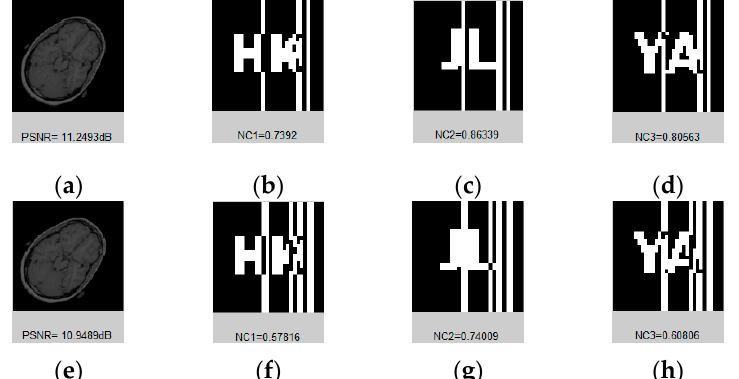
Figure 18. Under rotation attacks: ( a ) Rotation (clockwise) 40 ◦ ; ( b ) the extracted watermark 1 under rotation (clockwise) 40 ◦ ; ( c ) the extracted watermark 2 under rotation (clockwise) 40 ◦ ; ( d ) the extracted watermark 3 under rotation (clockwise) 40 ◦ ; ( e ) Rotation (clockwise) 45 ◦ ; ( f ) the extracted watermark 1 under rotation (clockwise) 45 ◦ ; ( g ) the extracted watermark 2 under rotation (clockwise) 45 ◦ ; ( h ) the extracted watermark 3 under rotation (clockwise) 45 ◦ . Table 6. Data of rotation attacks.